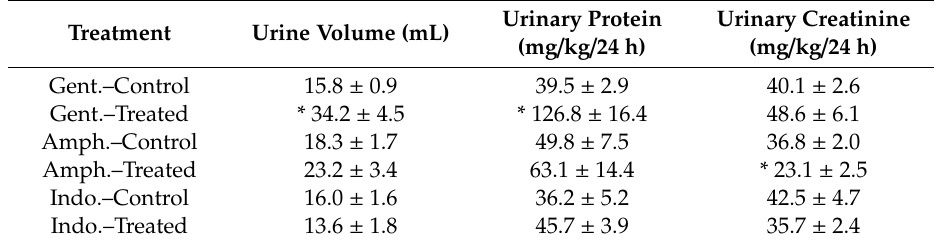
Table 1. Changes in urinary parameters after acute nephrotoxic doses of gentamicin, amphotericin and